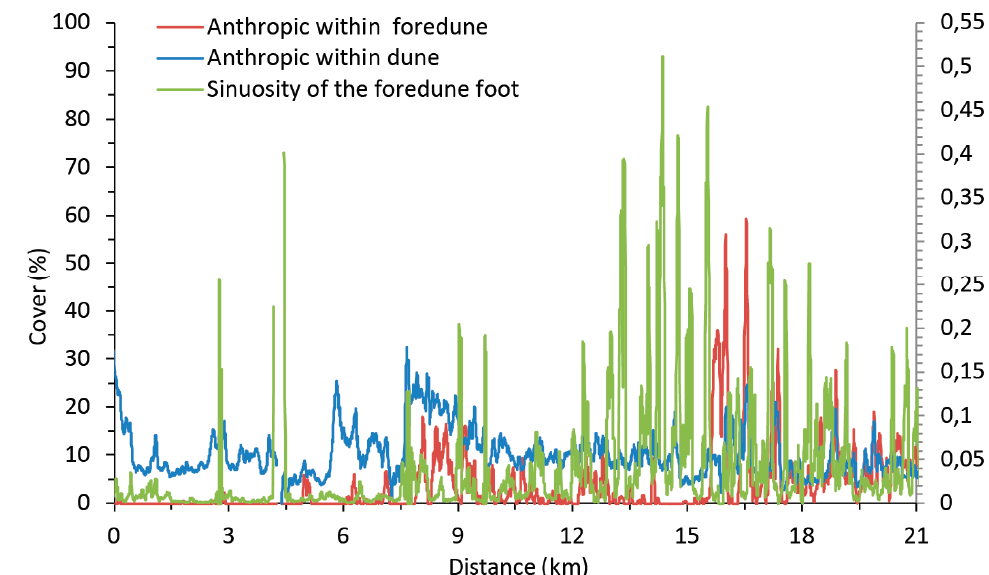
Figure 13. Foredune foot sinuosity (green) and dune anthropic cover (blue). While the anthropic cover is present all over the dune stretch, the foredune (red) shows an increasing presence moving south from 7 km onward.